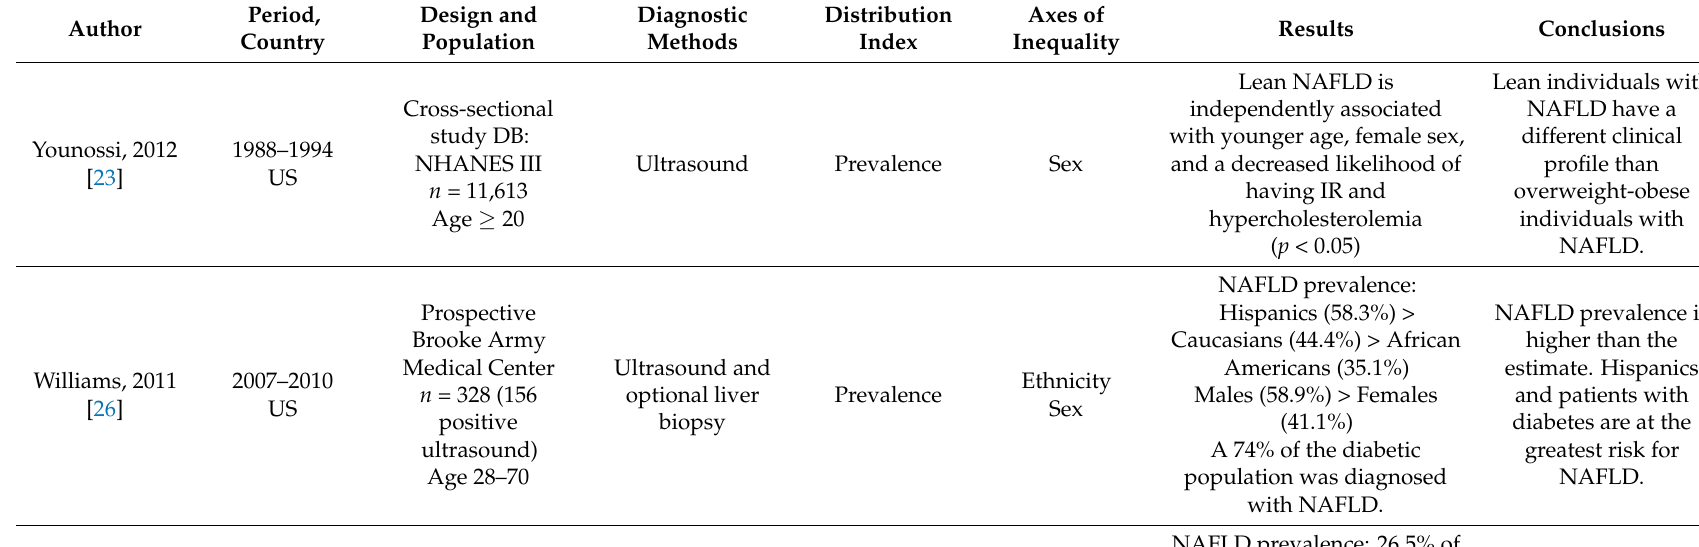
Table 1. Summary of included studies assessing NAFLD